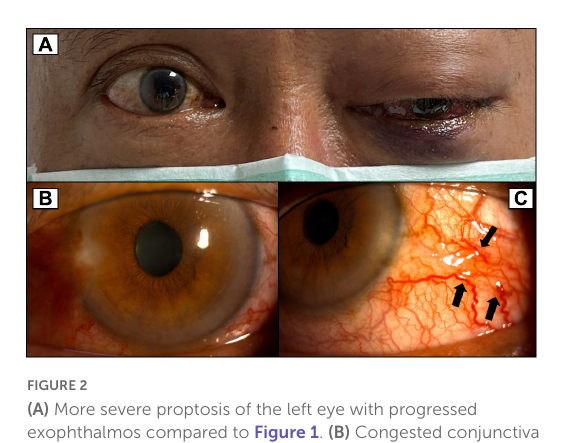
around 360 degrees of the left eye. (C) Corkscrew vessels on the conjunctiva (black arrows).